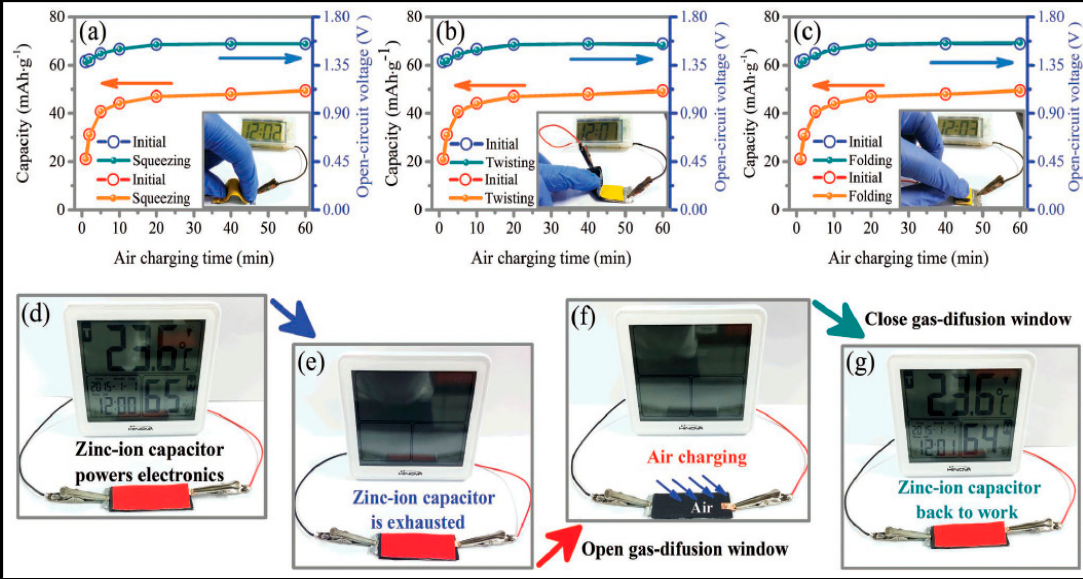
Figure 9. Demonstration of the “air chargeable” zinc-ion capacitor and its operation under various deformations: Capacity versus “air charging” time and corresponding open-circuit voltage of the capacitor under ( a ) squeezing, ( b ) twisting, and ( c ) folding and compressing deformations. ( d – g ) Demonstration of the process of “air chargeable” zinc-ion capacitor. ( d ) A zinc-ion capacitor is used to power a digital hygrometer, and ( e ) the zinc-ion capacitor is exhausted after working for several hours. ( f ) Then, the sealing tape is removed and air diffuses in and “air charging” is triggered. ( g ) The zinc-ion capacitor is successfully charged and starts to power the hygrometer again. Reproduced with permission from [156]. Copyright 2019 Wiley.